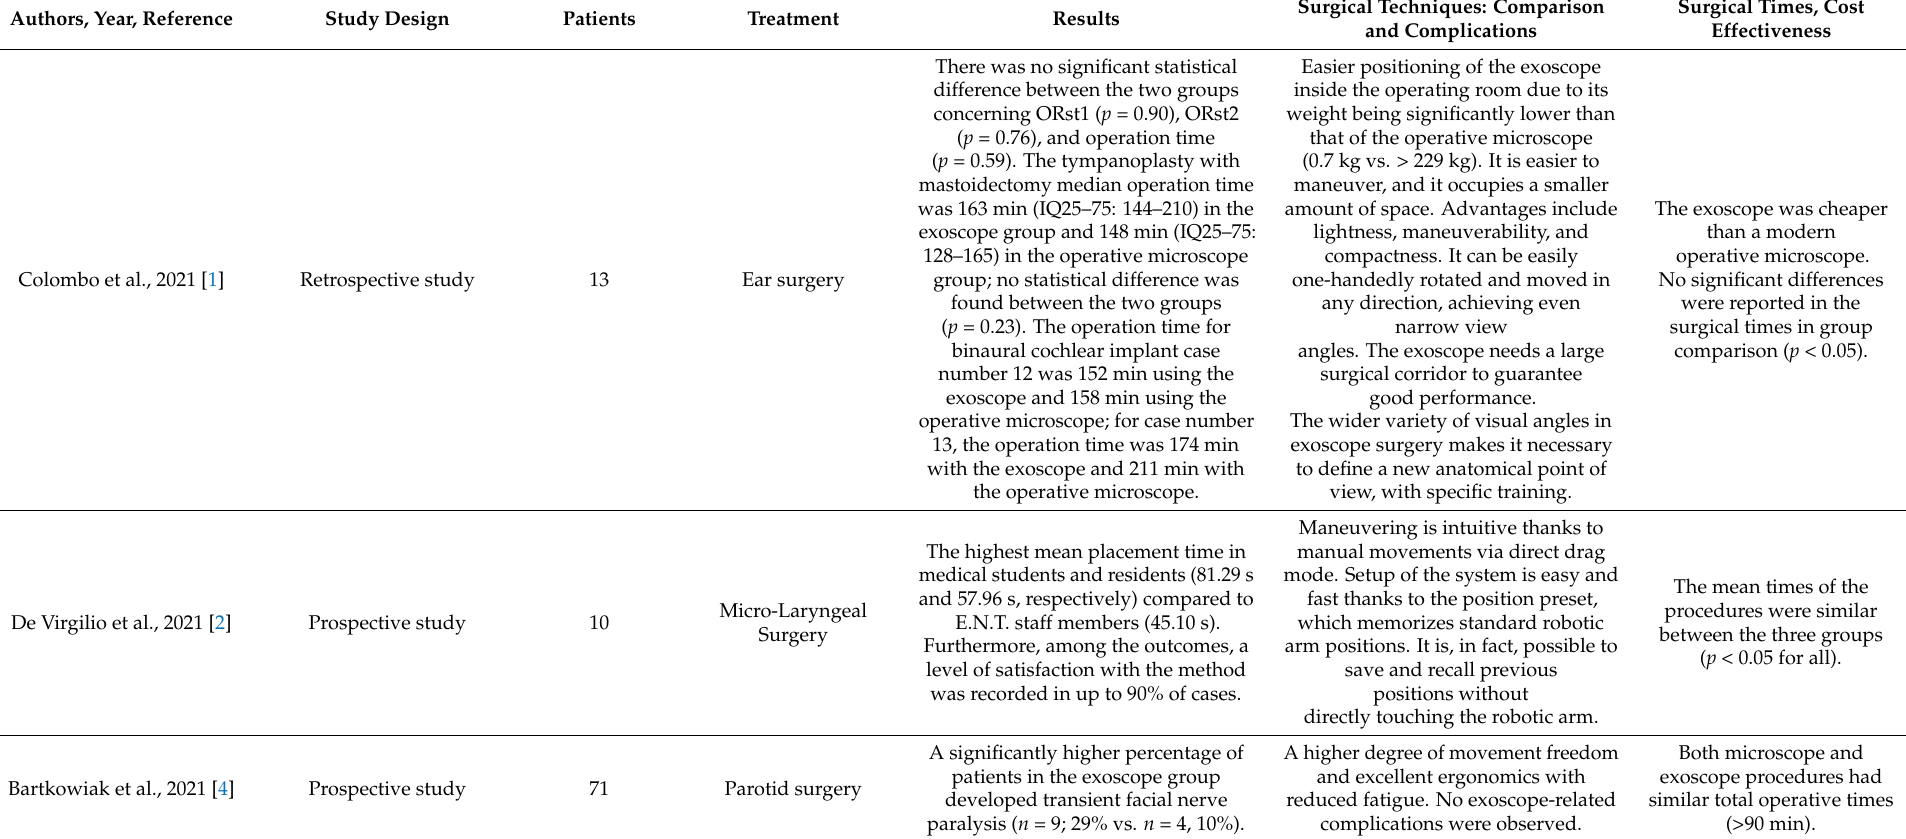
Table 1. Studies retrieved in qualitative analysis, outcomes comparison and cost